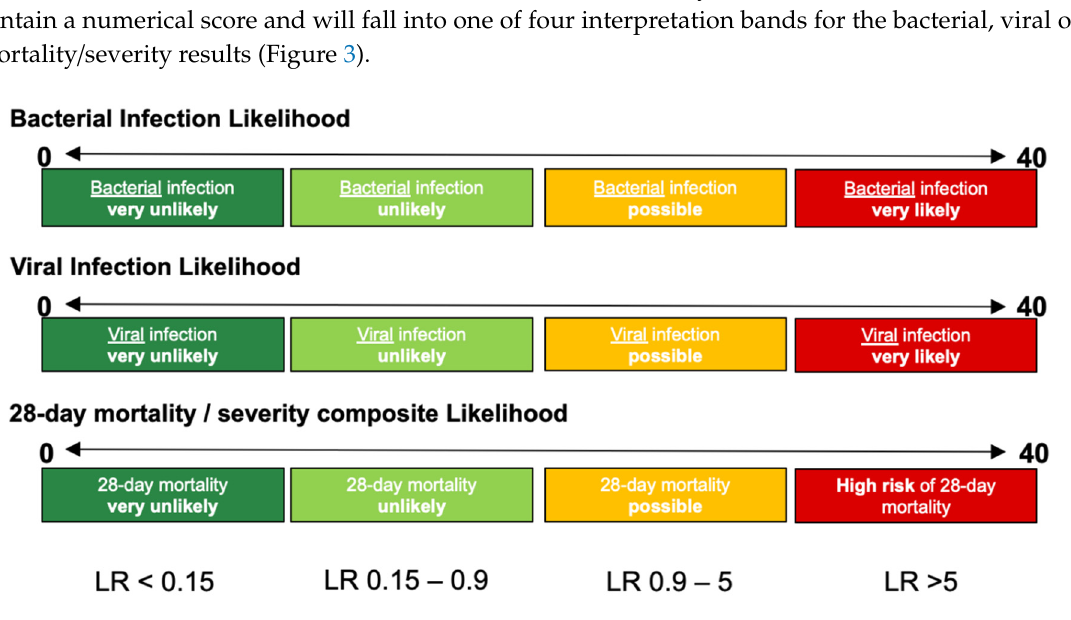
Figure 3. Proposed InSep result readout: Three separate results are provided, each containing an absolute score falling into one of the interpretation bands. There are 4 bands each for the bacterial, viral, and the severity score. Each band has different target likelihoods of the corresponding event.